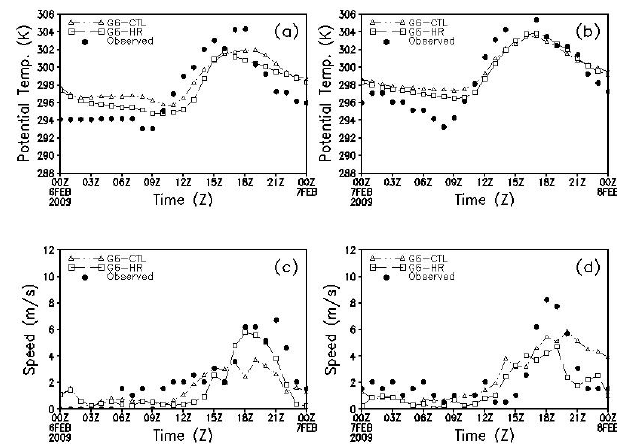
Figure 8. Time cross-section data of (a, b) θ (K), and (c, d) wind speed (ms − 1 ) observed (closed circle) and simulated by G5 of the CTL (open triangle) and HR (open square) runs from 00:00UTC 6 September to 00:00UTC 8 September 2007 at Ecologia Agricola surface weather-observation station.